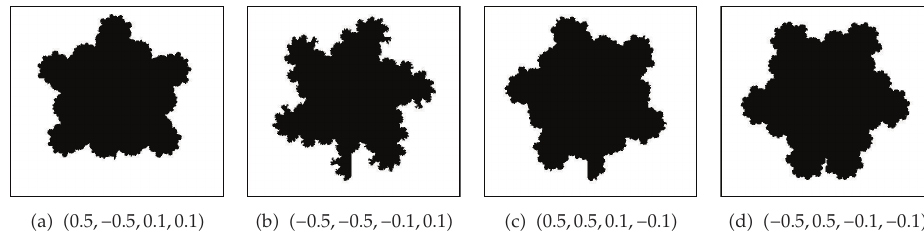
Figure 16: The generalized J sets perturbed by multiplicative noise when α (cid:6) 5 . 5, θ ∈ (cid:7) − 3 π/ 2 ,π/ 2 (cid:4)